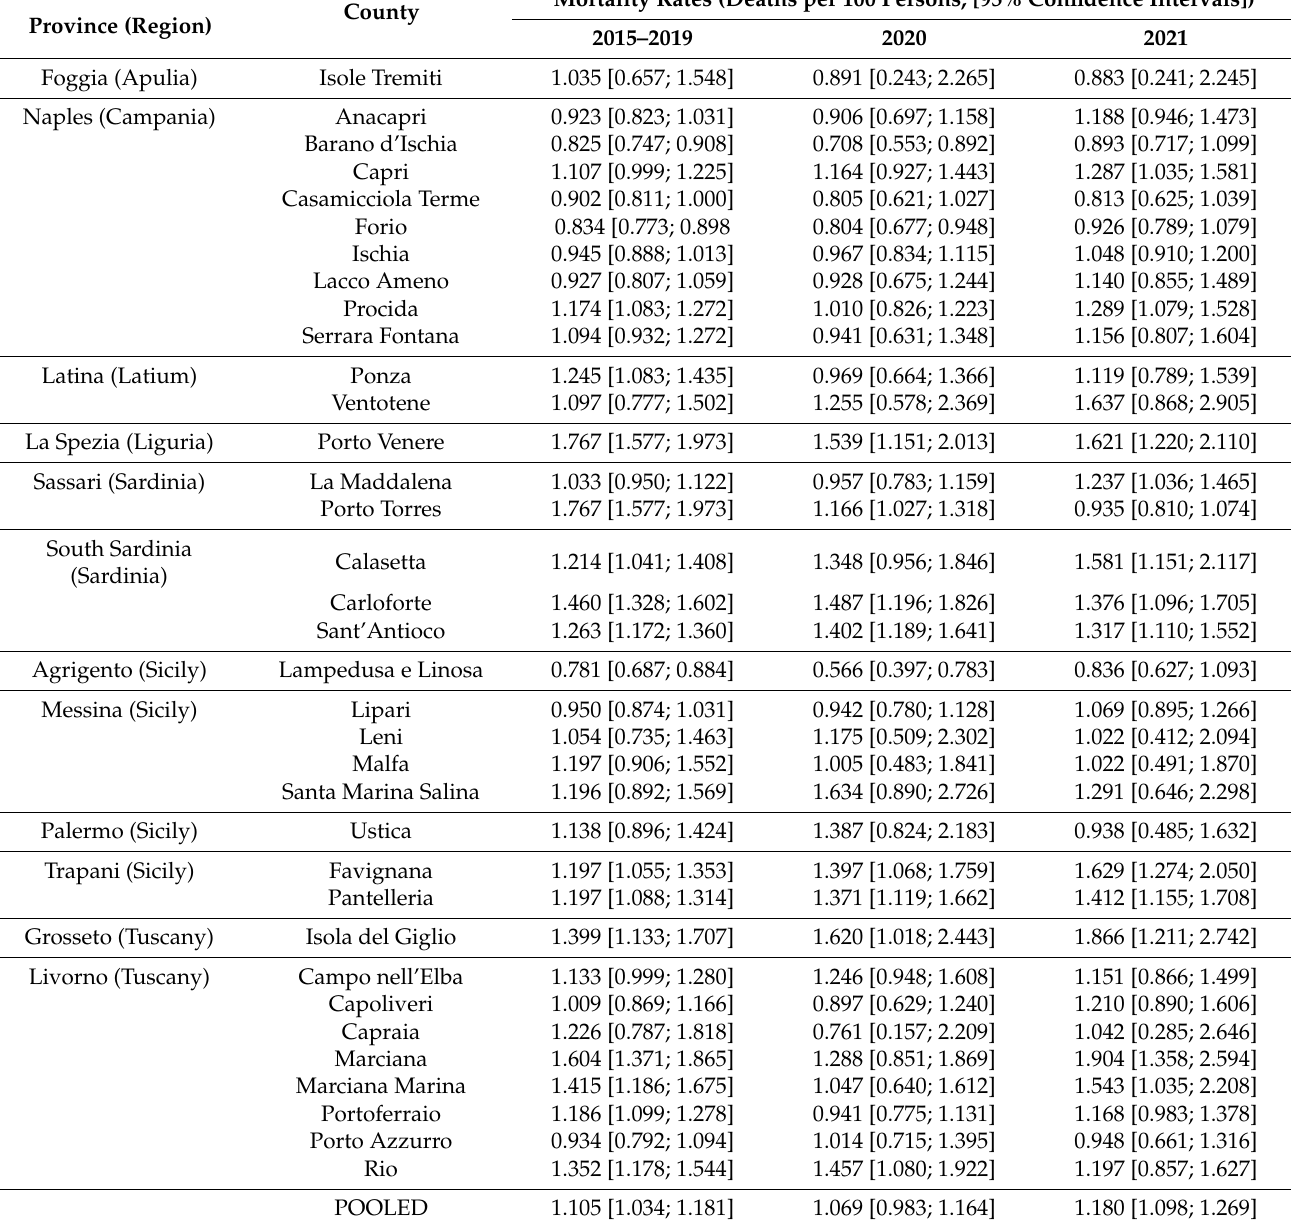
Table 2. Yearly mortality rates on Italian small